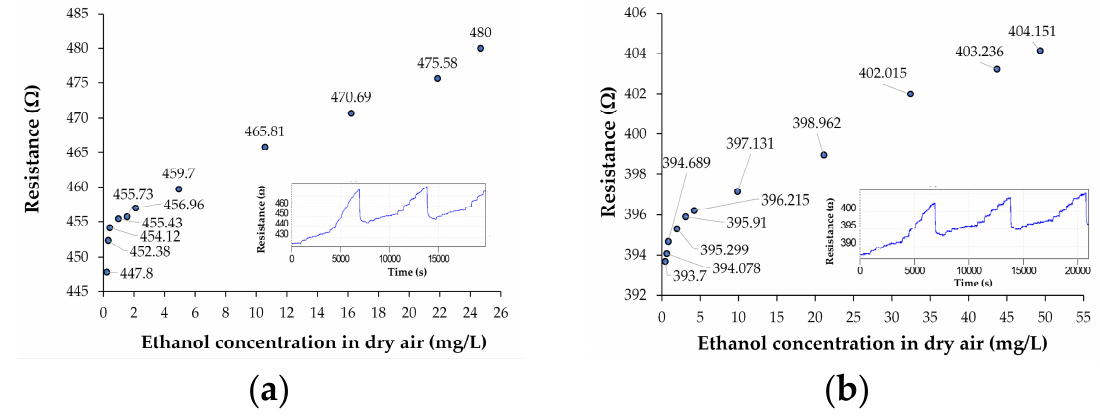
Figure 3. Transfer functions of the chemiresistive ethanol sensors with sensing films kept at room temperature and consisting of ( a ) ox-SWCNH / SnO 2 / PVP = 1 / 1 / 1 (mass ratio) and ( b ) ox-SWCNH / SnO 2 / PVP = 2 / 1 / 1 (mass ratio). For both cases, the flow rate of air passing through liquid ethanol was varied, while the total flow rate was kept constant at 1 L / min. The inset shows the automatic recording of the sensor resistance as a function of time and ethanol vapor concentration.